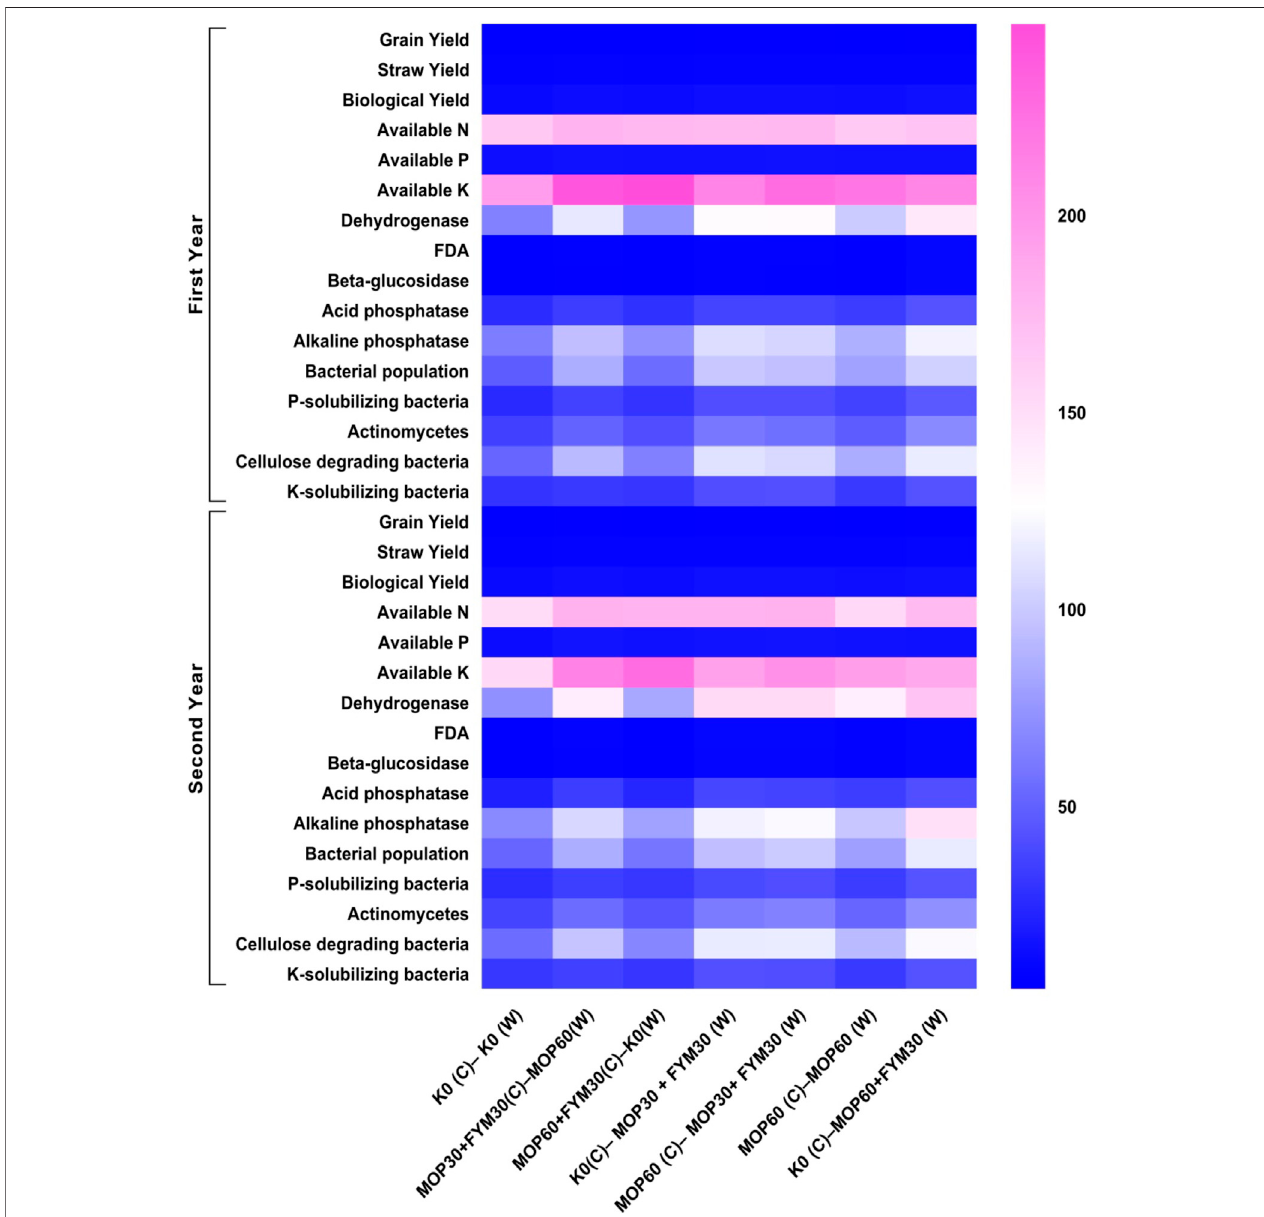
FIGURE 7 | Expression pattern of various soil biological activities, available nutrients, microbial population, and yield of wheat for consecutive two years.